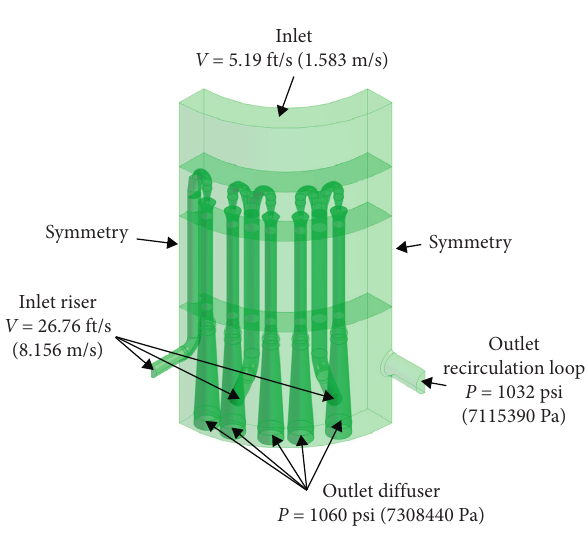
Figure 7: Control volume and its boundary conditions.